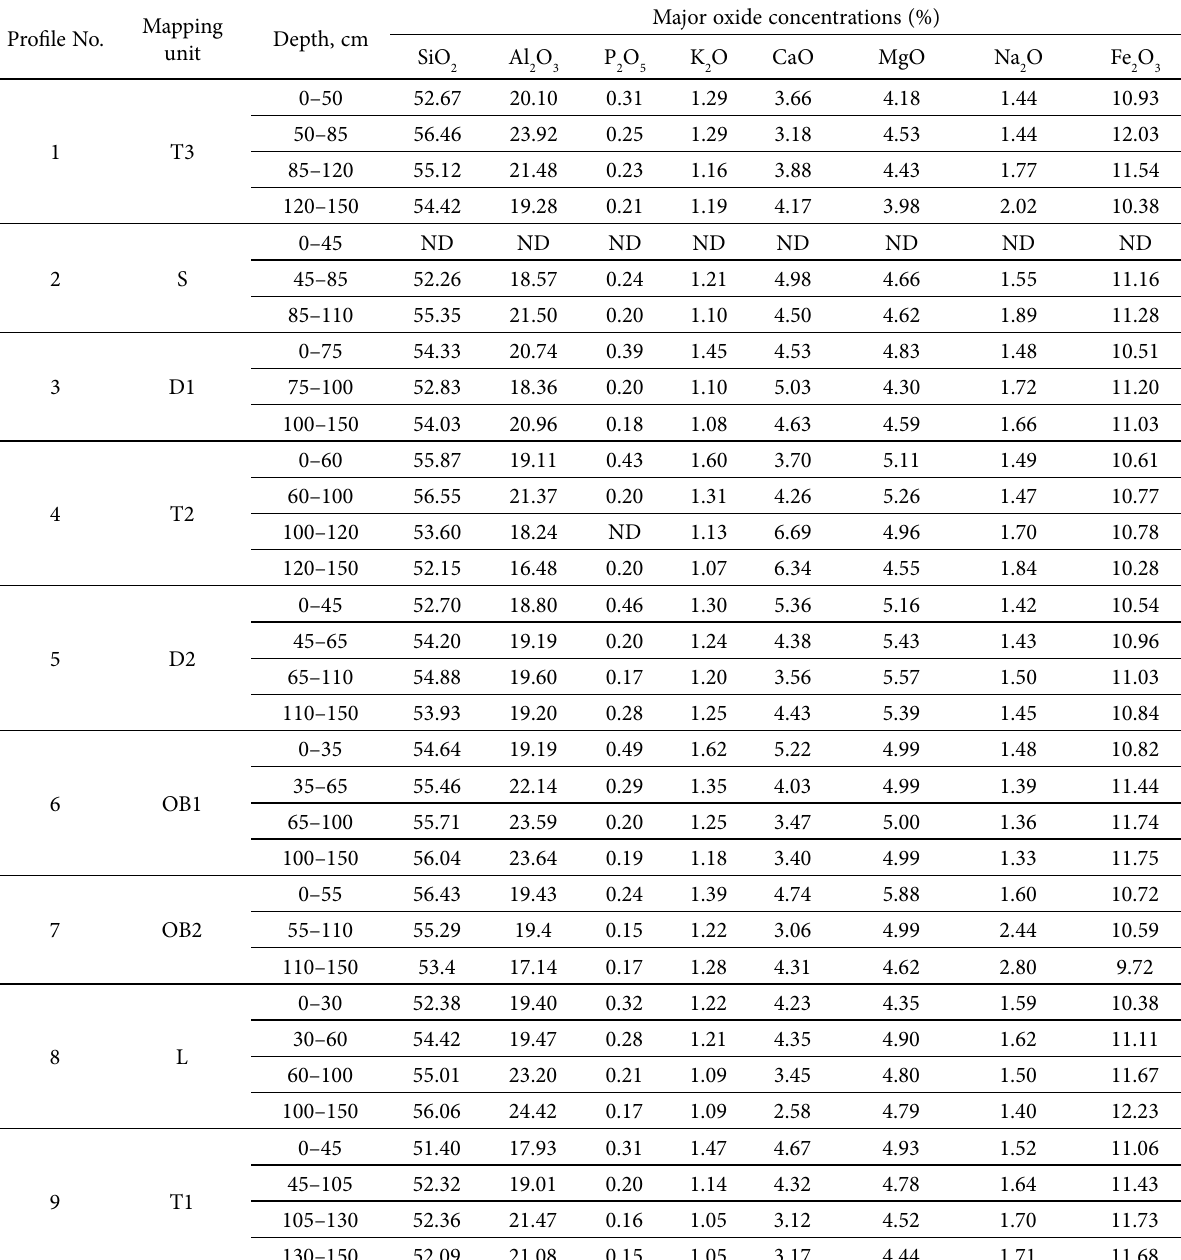
Table 7. Summary of major oxide concentrations in soil samples of the study area Profile